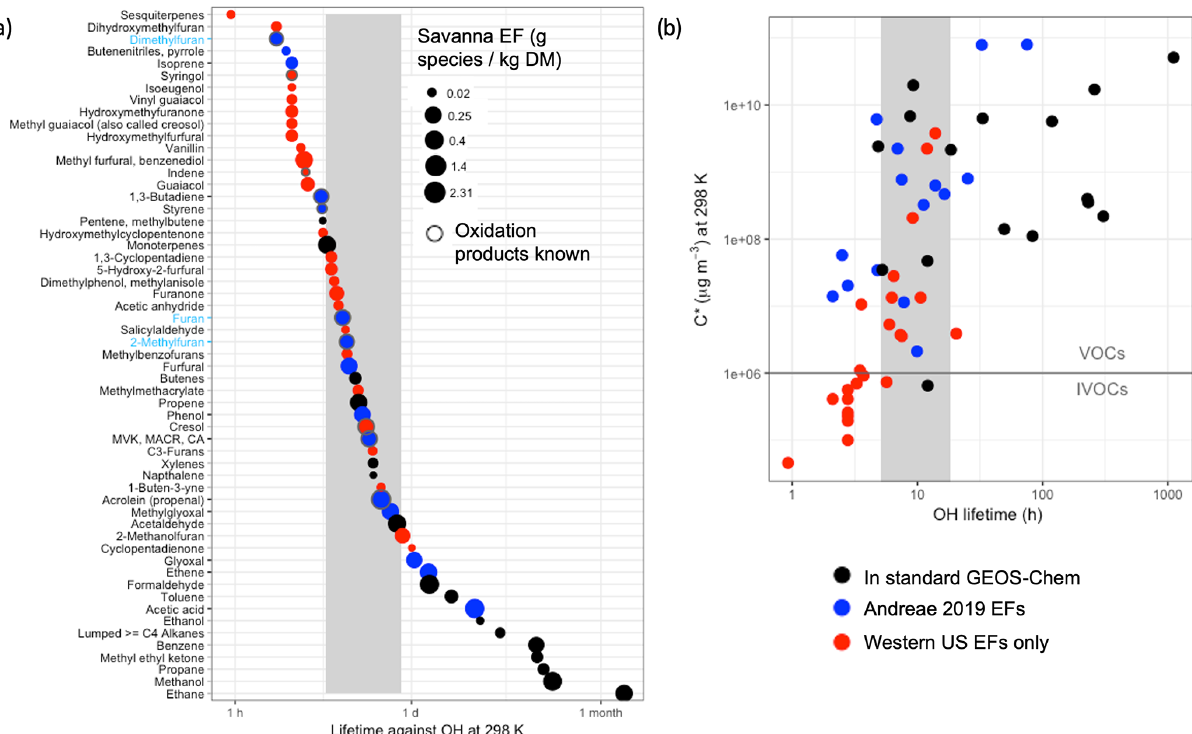
Figure 1. (a) NMOGs emitted from fires, shown in descending order of chemical lifetime due to oxidation by OH (at 298K with an assumed concentration of 1 × 10 6 molec.cm − 3 ). Only the species responsible for 95% of OHR from fires are shown (following Coggon et al., 2019). Fire NMOGs included in the standard GEOS-Chem model are in black, species for which fire emissions are not included in the standard GEOS-Chem model but for which emissions factors are available in Andreae (2019) are in blue, and species that are only available for western US fuel types from Koss et al. (2018) are in red. The y -axis tick marks are in black for fire NMOGs added to GEOS-Chem in this study and in blue (with blue labels) when both the fire NMOG and its oxidation chemistry were added. The points are sized by their relative savanna and grassland (labeled “savanna”) emission factor in gram species per kilogram DM burned. The grey vertical box represents an approximate physical lifetime against transport out of a nested 0.5 ◦ × 0.625 ◦ grid box ( ∼ 5h) and a 2 ◦ × 2.5 ◦ grid box ( ∼ 20h). CA stands for crotonaldehyde. (b) Plot of volatility (C*) against OH lifetime for the species shown in (a) using the same color conventions. The horizontal line separates VOCs from IVOCs based on their